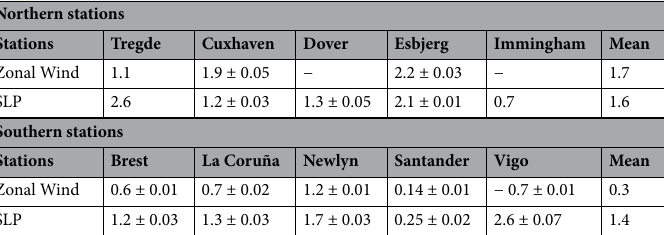
Table 2. Linear trends (day/decade) in the timing of the storm season at each station for the zonal wind and SLP between 1950 and 2000. Trends for the zonal wind are not displayed at Immingham and Dover, as these stations are not impacted by zonal wind 33 (see text). Standard errors are 1 σ . Note that the meteorological data are not extracted at the point closest to the station, but at the point where the correlation with the storm surge is maximum (see